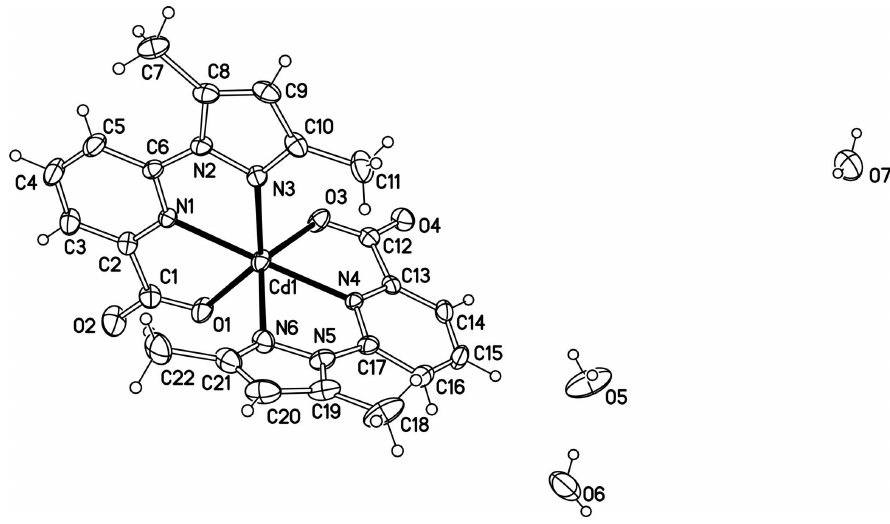
Figure 1 The molecular structure of (I) showing 50% probability displacement ellipsoids and the atom-numbering